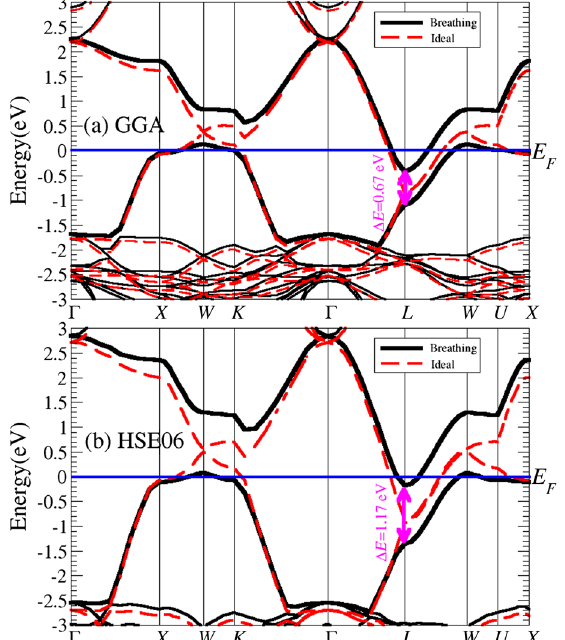
FIG. 3. Illustration of the big REPME of the oxygen-breathing . The band structures of BaBiO mode at the R point in BaBiO 3 3 with and without the oxygen-breathing displacement are calcu- lated by DFT using both the (a) GGA and (b) HSE06 hybrid functionals. We plot the band structure in the Brillouin zone of the fcc unit cell, corresponding to a 2 (cid:5) 2 (cid:5) 2 supercell of the simple cubic unit cell due to the oxygen-breathing distortion. The displacement of each oxygen is about 0.044 A˚ in the calculations. The band splittings indicated by the arrows are about 1.17 eV for the DFT HSE06 and 0.67 eV for the DFT GGA, resulting in REPMEs of about 13.3 and 7 : 6 eV = (cid:3)A , re- spectively. The corresponding scQP GW values are 1.10 eV and 12 : 5 eV = (cid:3)A , respectively. Note that the material remains metallic with the oxygen-breathing